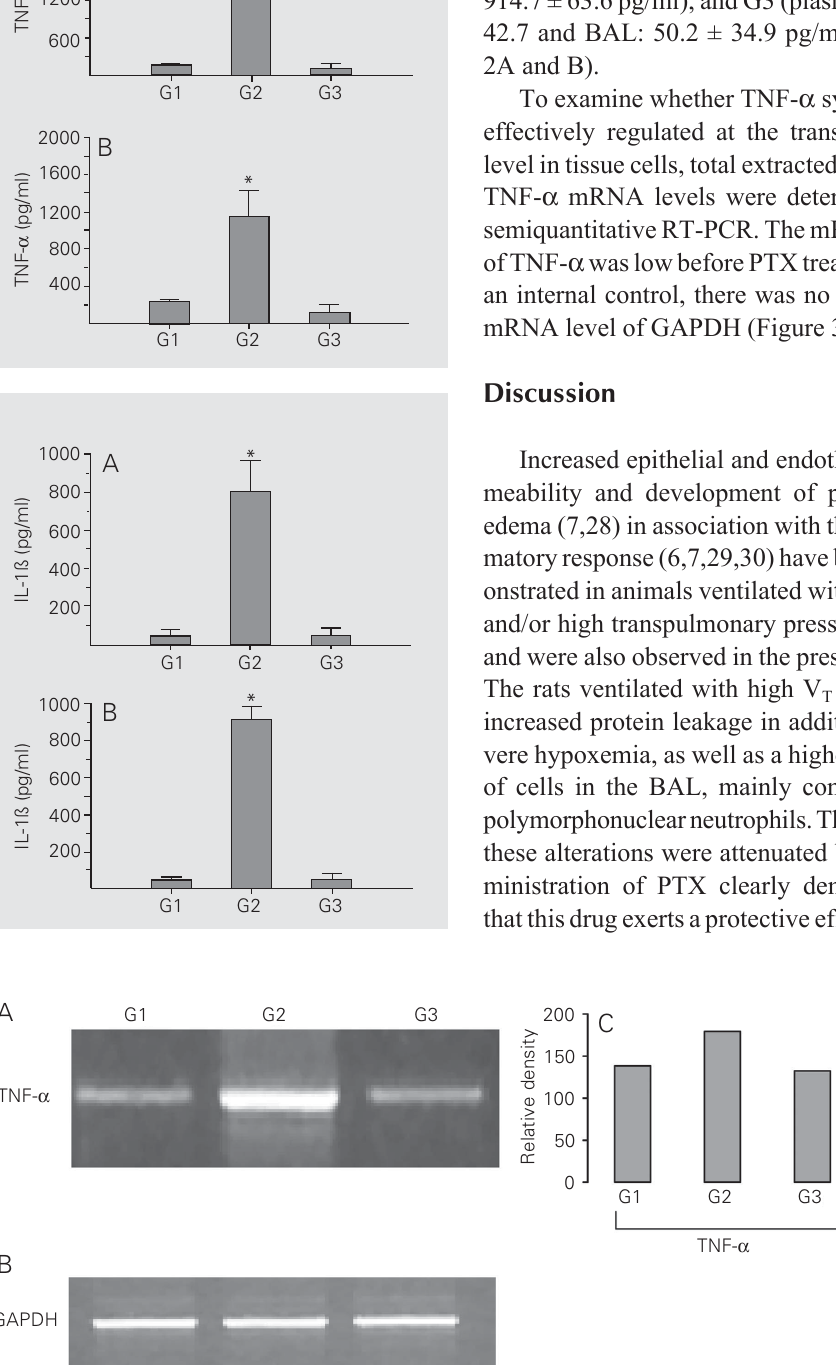
1. Effect of pentoxifylline (PTX) on TNF- α levels in plasma (A) and bronchoalveolar lavage (B) of rats under mechanical ven- tilation. Data are reported as means ± SD. G1 (V T = 7 ml/kg with normal saline infusion; N = 7); G2 (V T = 42 ml/kg with nor- mal saline infusion; N = 7), and G3 (V T = 42 ml/kg with PTX infu- sion (50 mg/kg); N = 7). A , *P < 0.001 for G2 vs G1 vs G3. B , *P < 0.001 for G2 vs G1 vs G3